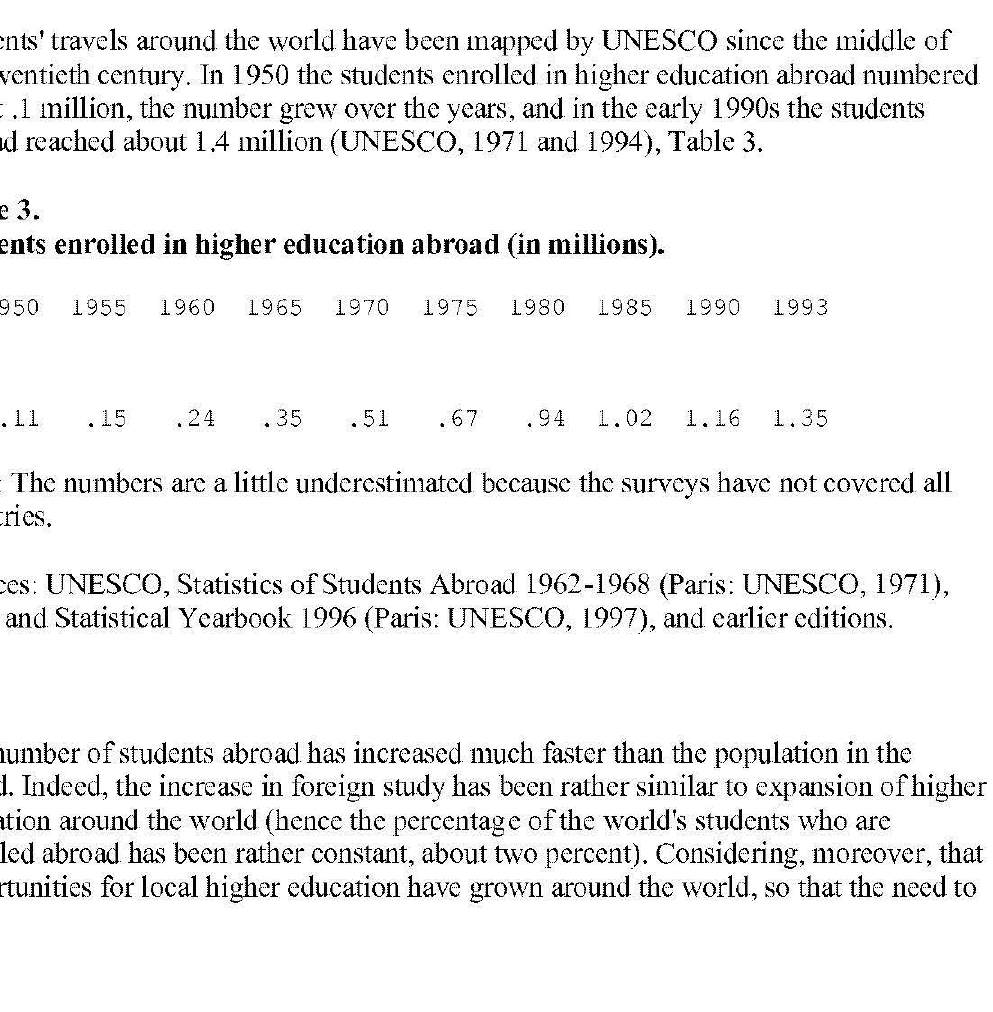
Students enrolled in higher education abroad (in